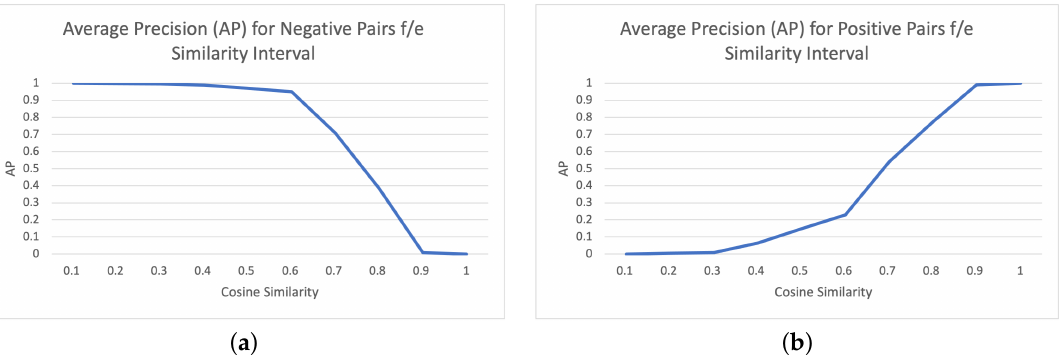
Figure 4. Average precision per cosine similarity interval for positive and negative pairs. ( a ) Average precision for negative pairs. ( b ) Average precision for positive